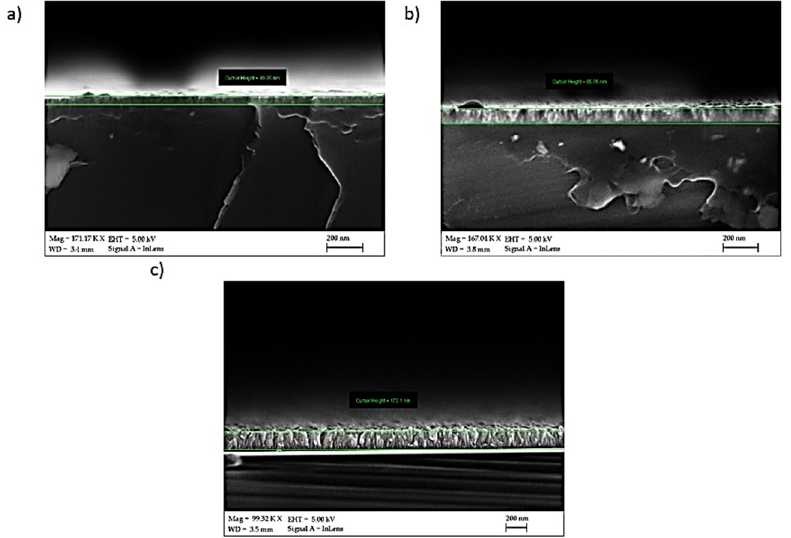
Figure 6. SEM surface topography images of the ZnO thin film deposited after ( a ) 500 cycles, ( b ) 1000 cycles, and ( c ) 1500 cycles.